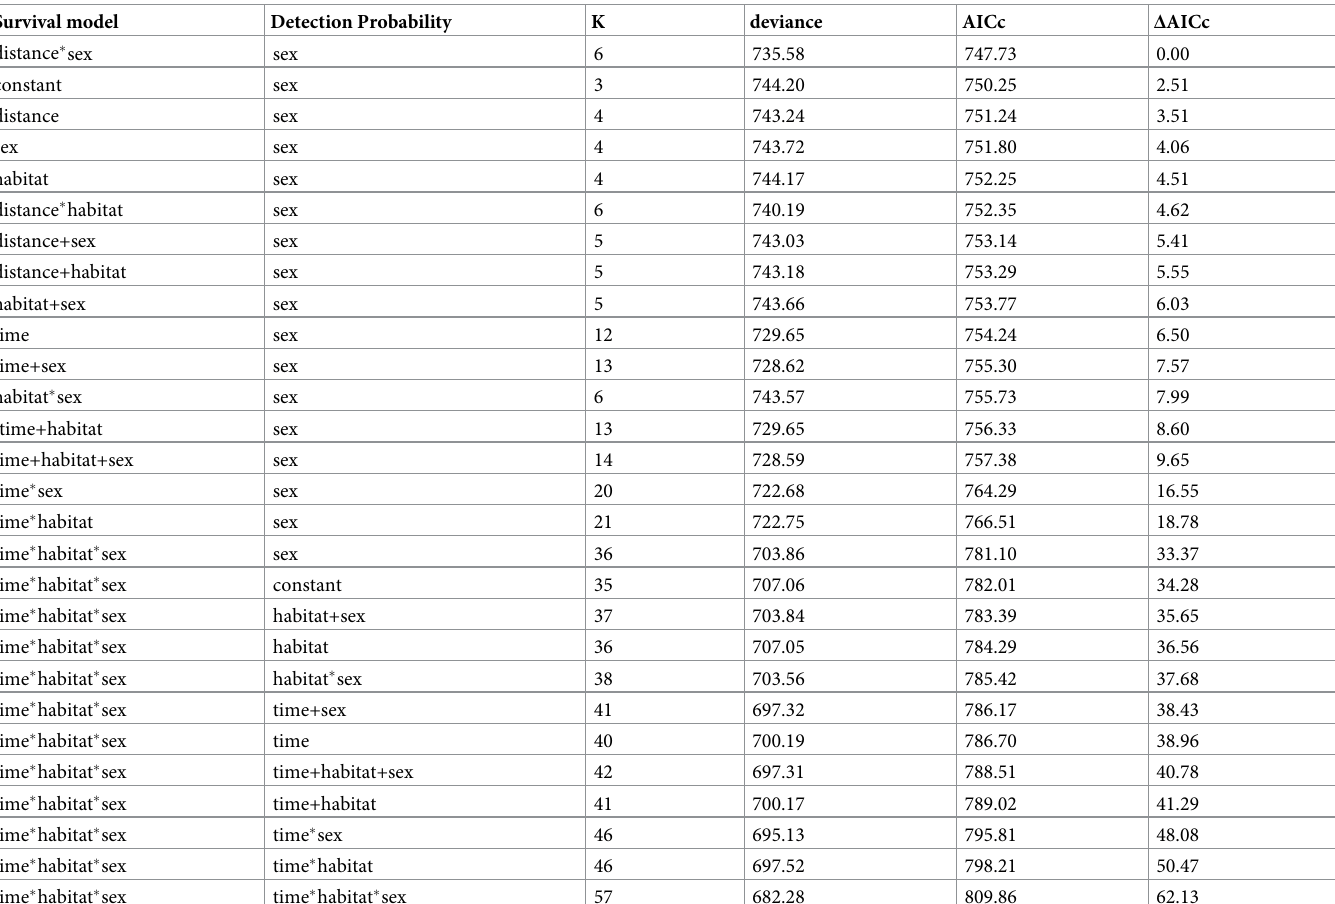
Table 5. Model comparison to assess the effects of natal dispersal distances (distance) on immediate survival probabilities of urban and rural (habitat) burrowing owls Athene cunicularia . K: number of estimated parameters in approximating model, AICc: Akaike information criteria with small sample bias adjustment, Δ AICc: dif- ference between each model and the best model (i.e., the model with the lowest AICc), deviance: deviance explained by each